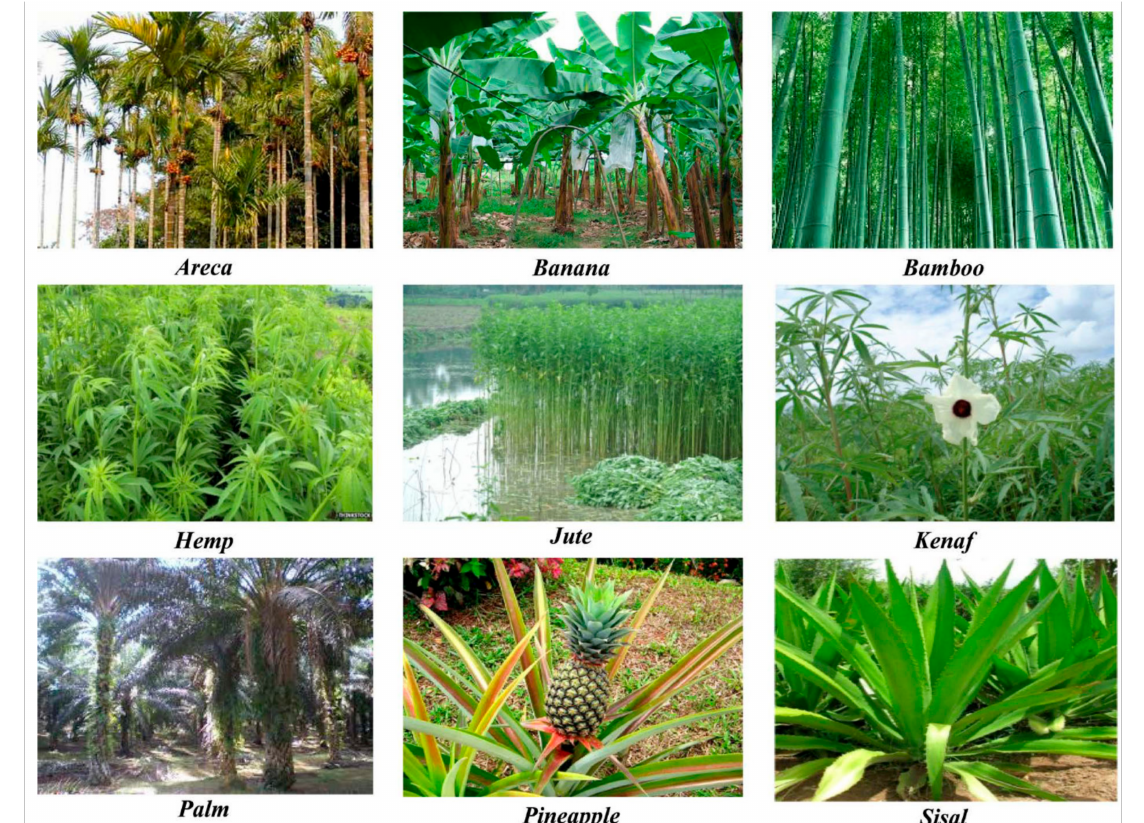
Figure 5. Types of natural plant Fibers Reprinted with permission from the publisher [50]. Open access.